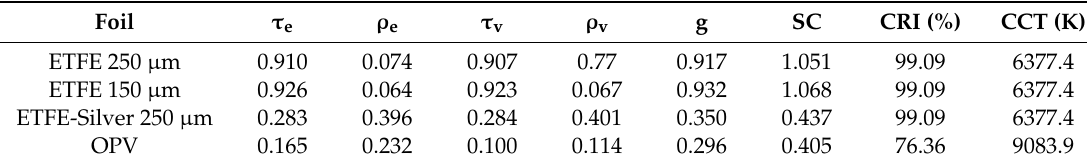
Table 1. Summary of luminous and solar characteristics.